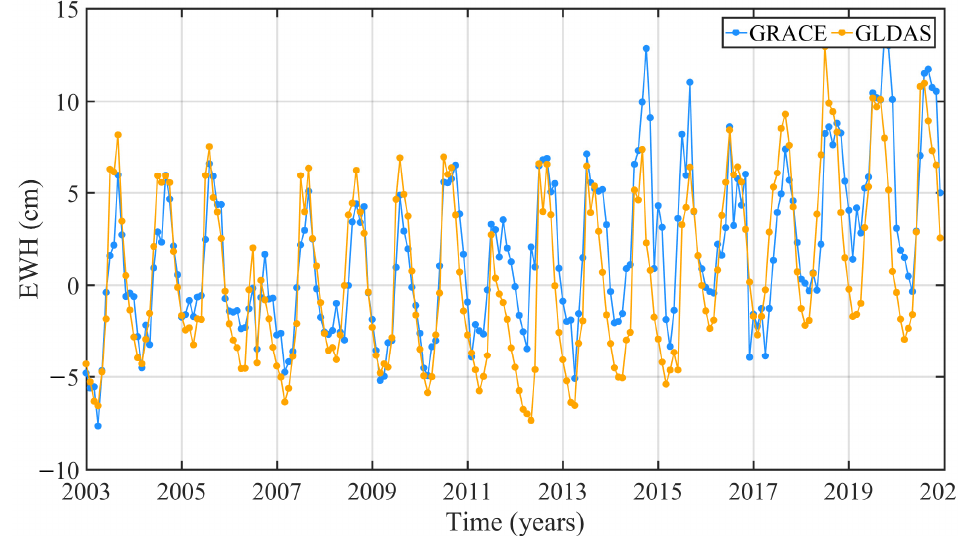
Figure 5. The time-series of TWSC from the fused results and GLDAS 2.1 model. Table 4. The long-term change trend of TWSC in Sichuan Province (unit: mm/a).